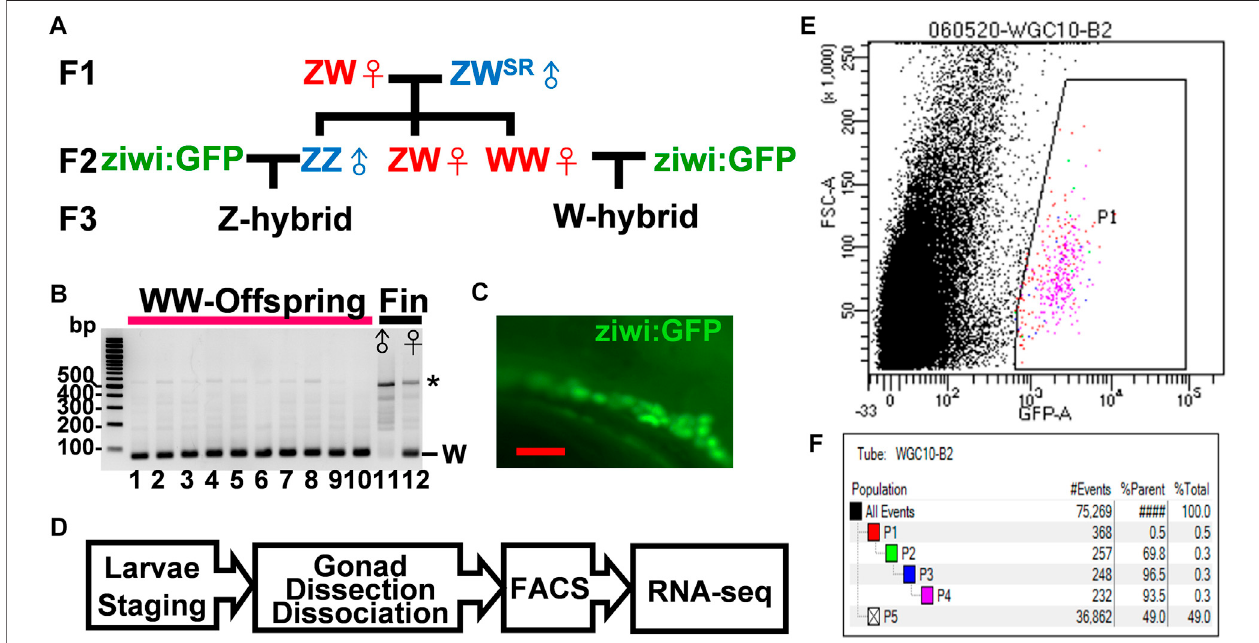
FIGURE 1 | Isolation of germ cells from juvenile zebra fi sh with de fi ned sex. (A) . The fl ow chart for the generation of W- and Z-hybrids. Sex-reversed ZW SR Nadia males were crossed with ZW females to obtain the WW females in the F2 generation. The WW and ZZ fi sh were each mated with the Tg (ziwi: GFP) in the TL genetic background to obtain W- or Z-hybrid offspring with fl uorescent germ cells. (B) . Gel electrophoresis showing the detection of the W-fragment in the genome of 10 offsprings from the WW mother after PCR ampli fi cation (lanes 1 – 10). Lanes 11 and 12 are genomic DNAs from the fi n of a male and a female of the Nadia strain as controls,respectively.TheWfragmentis86bpsinlength.Thestarmarksnonspeci fi cPCRbands. (C) .ThegonadofaTg(ziwi:GFP) fi shwith fl uorescentgermcells. (D) . The fl ow chart for transcriptome analysis. Larvae were fi rst staged to ensure proper development before their gonads were dissected. Their germ cells were then dissociated and sorted by FACSbeforeRNA-seqanalysis. (E) . Arepresentative FACS plot shows the selection ofGFP-positivegerm cells(P1). (F) . Atypical FACS data set showing the procurement of 232 GFP + germ cells (pink group, 0.3% of all cells). Blue-group (P3) and pink-group (P4) cells were obtained after cell size quantity control. The green group (P2) selects for live cells that do not stain with propidium iodide. Black dots represent other cells and cell debris.